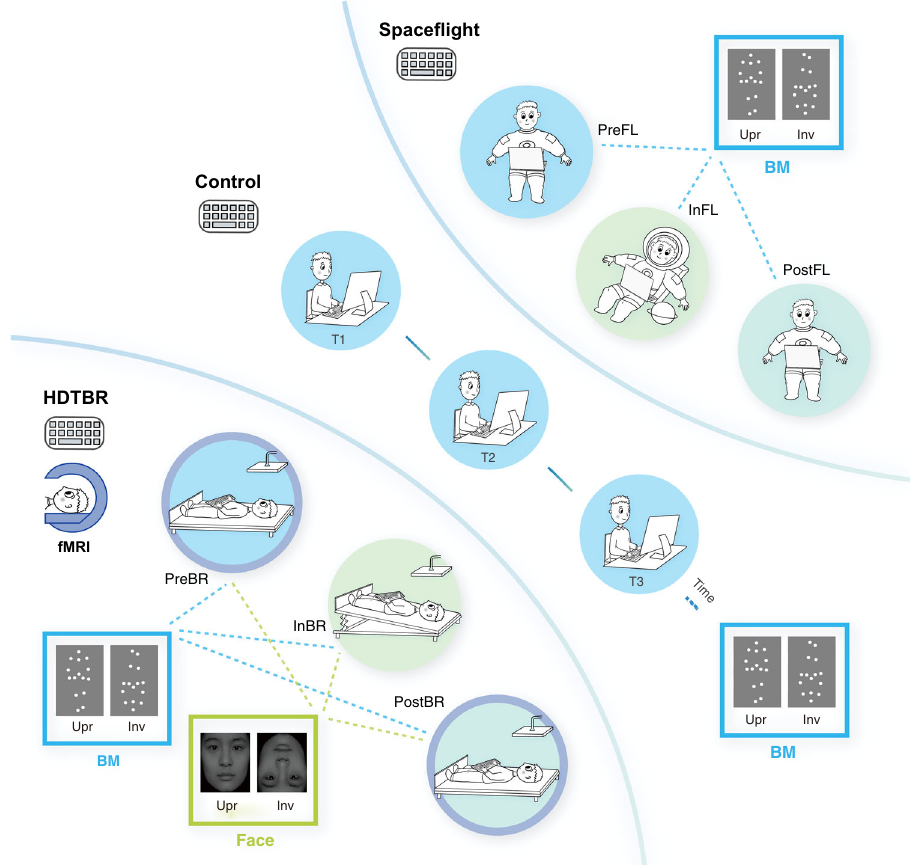
Fig. 1 Schematic schedules of the space experiment (upper right panel), the ground-based control experiments (middle panel), and the 6° head-down tilt bed rest (HDTBR) space analog experiment (lower left panel). Participants performed a biological motion (BM) perception task before, during, and after the space fl ight/HDTBR, or throughout the control experiments. Besides, participants in the HDTBR experiment completed a face perception task in addition to the BM task during each test session and underwent two fMRI scanning sessions before and after the bed